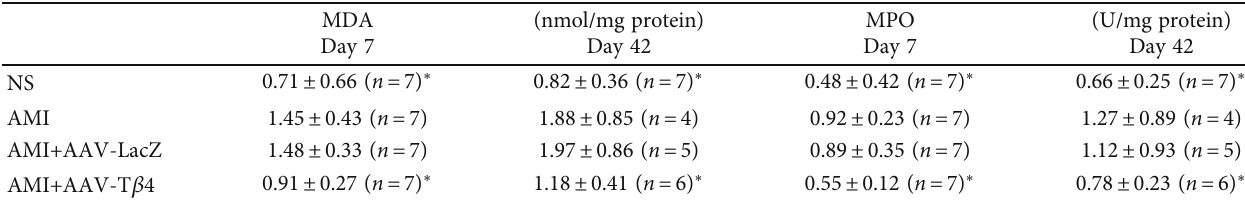
+ AAV-LacZ groups, 42 d following ligation. In comparison sion of α -SMA in the mouse heart, as indicated by RT- PCR (Figure 5(e)), Western blot (Figure 5(f)), and IHC